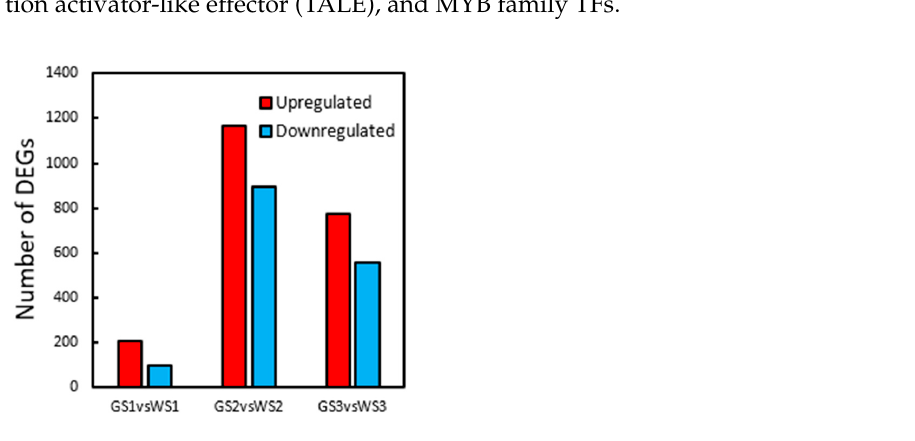
Figure 3. Differentially expressed genes (DEGs) between green and white pools at each stage of flower development.